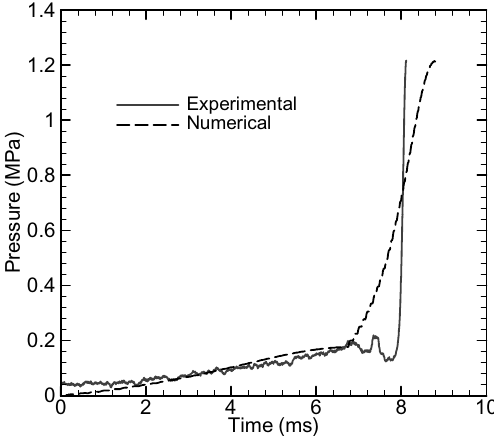
Fig. 12. Comparison of measured pressure on the base of device B (obtained from the Hopkinson bar test) with numerical prediction.